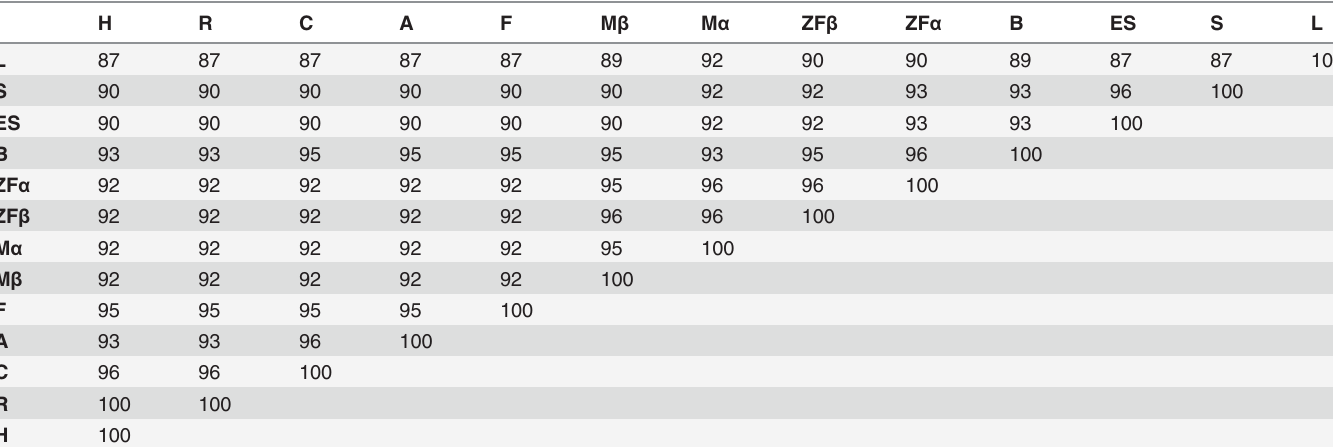
The numbers in the table correspond to percent sequence identity. Key: Lamprey (L), Skate (S), Elephant Shark (ES), Bichir (B), Zebra fi sh α (ZF α ), Zebra fi sh β (ZF β ), Medaka α (M α ), Medaka β (M β ), Frog (F), Alligator (A), Chicken (C), Rat (R), Human (H).